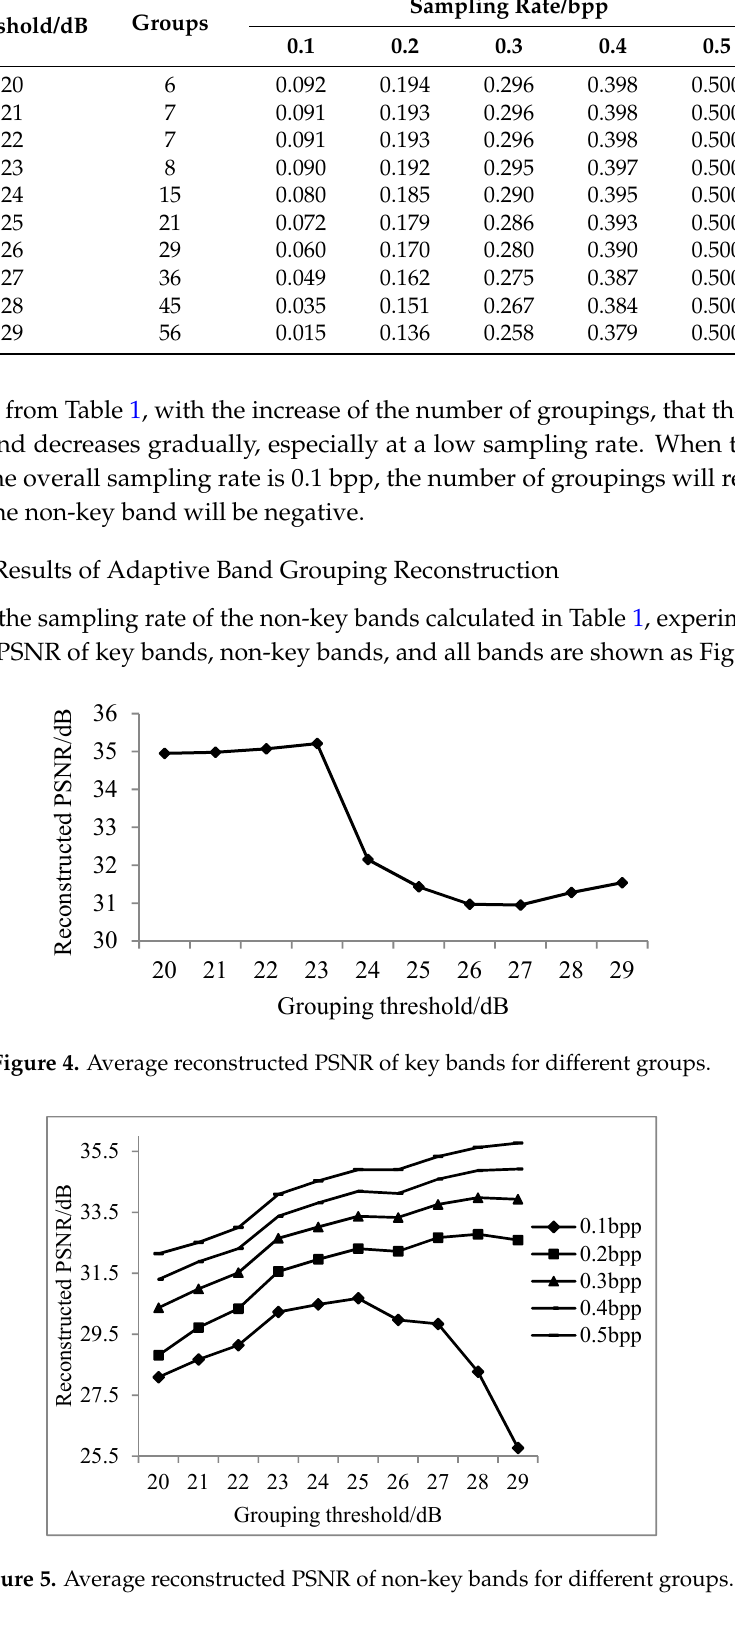
Figure 6. Average reconstructed PSNR of all bands for different groups.